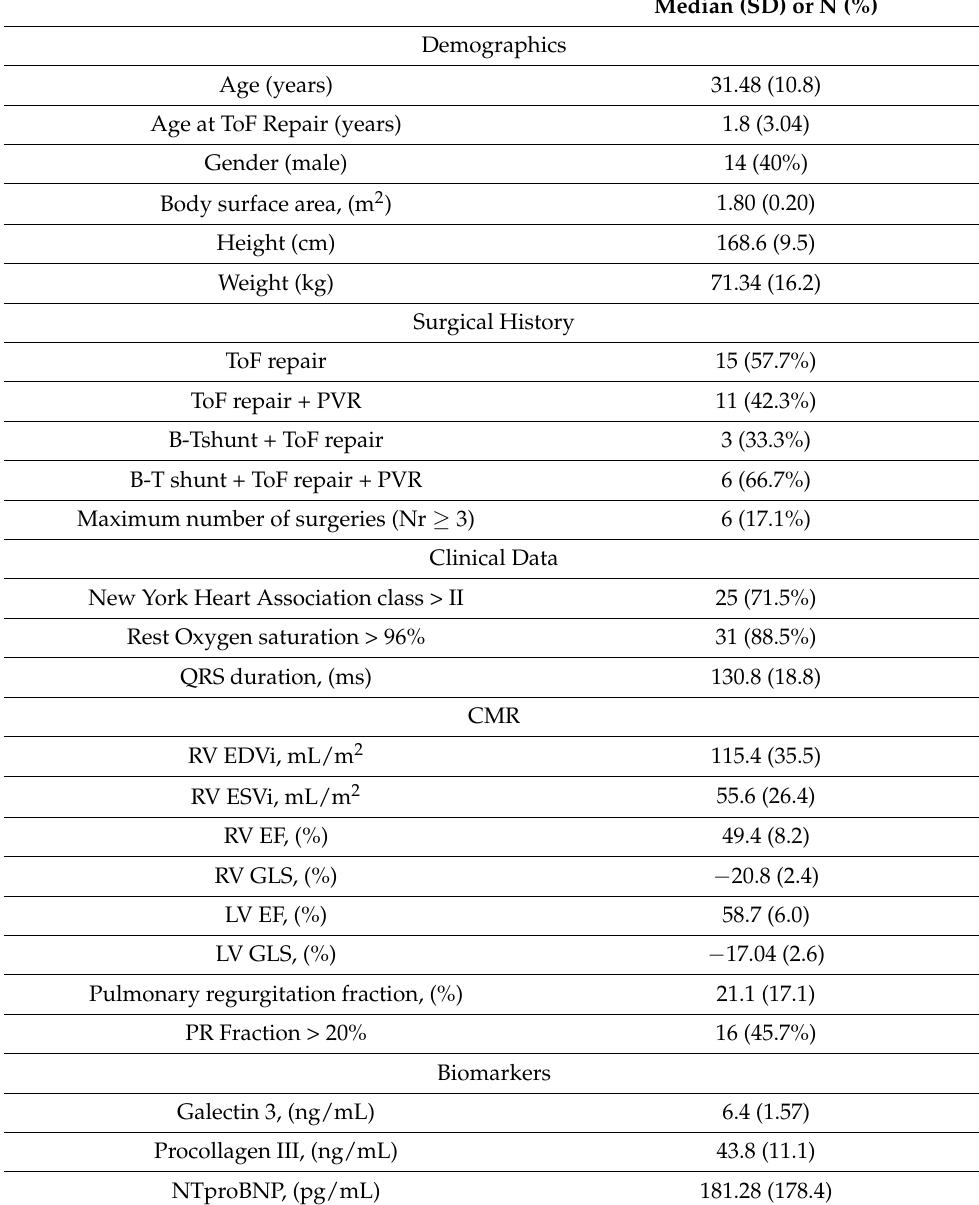
Table 1. Demographics, clinical characteristics, CMR data and biomarker levels of 35 adult patients with rToF